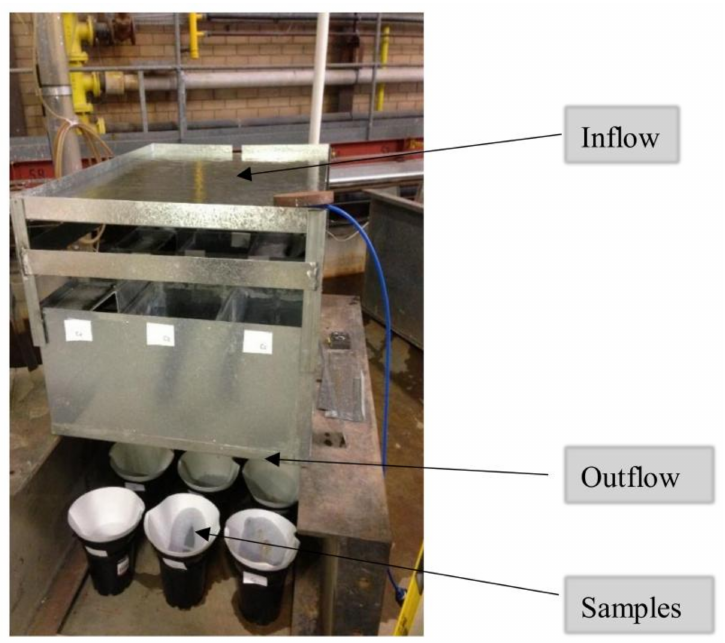
Figure 5. The inflow, outflow, and sampling locations.